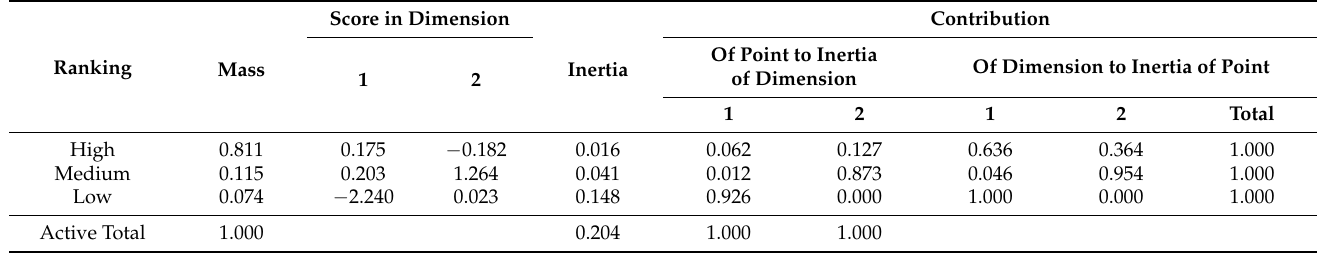
Table A5. Overview of correspondence score by row. Positioning and traffic obtained from social networks.